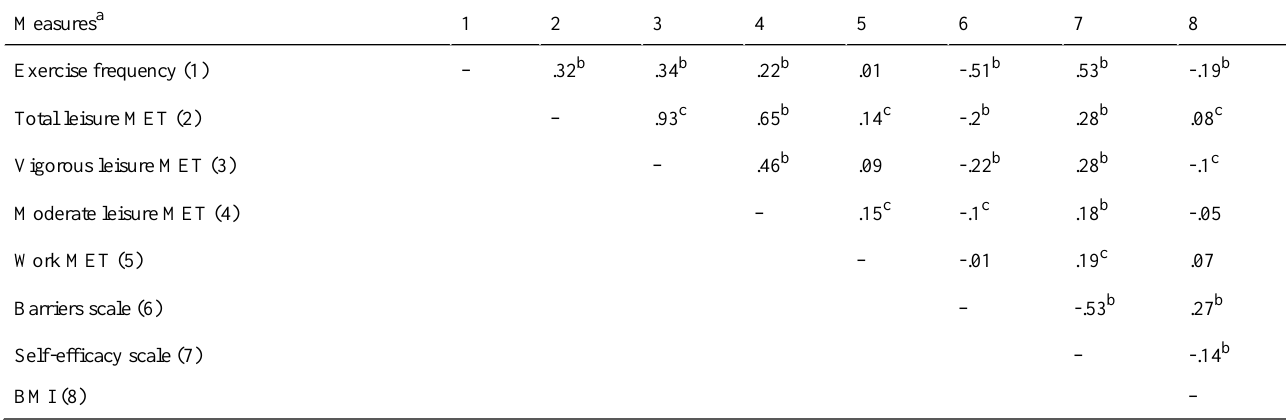
Table 1. Zero-order correlations for the total sample (zero-order correlations between all outcome measures, mediators, and moderators).